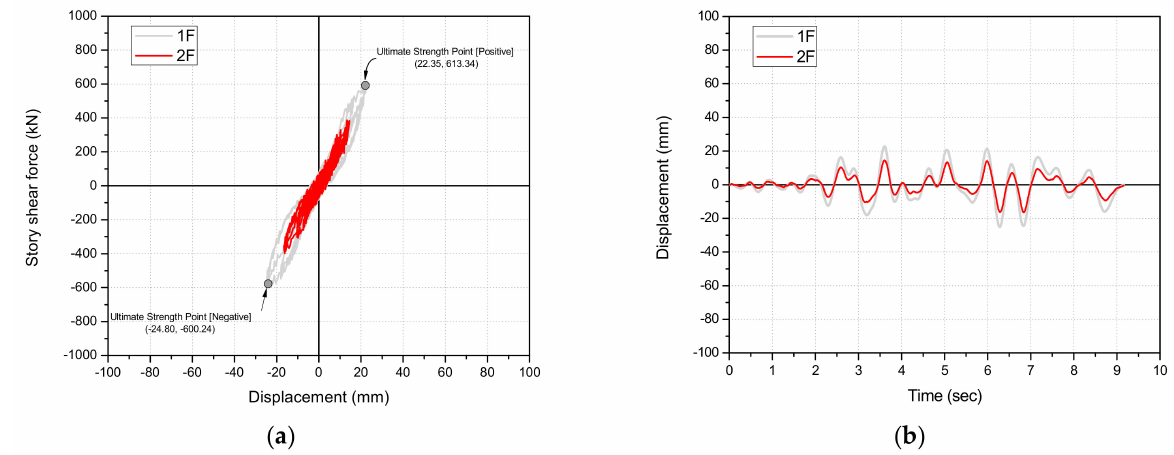
Figure 16. Seismic response load-displacement and displacement-time hysteresis curves (PD-CFT-MF, 300 cm/s 2 ): ( a ) load- displacement curves; ( b ) displacement-time hysteresis curves.